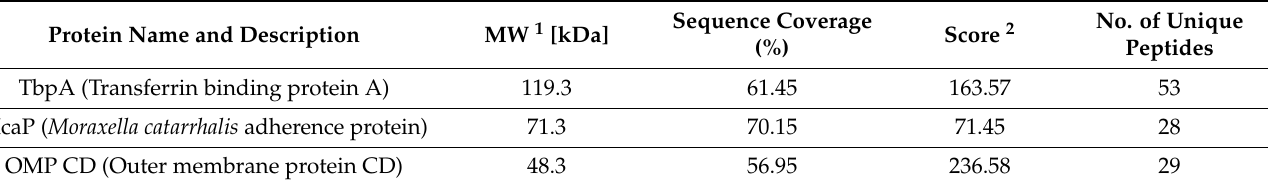
Table 1. OMPs proteolytically cleaved by NE as determined by LC-MS/MS spectrometry. Protein Name and